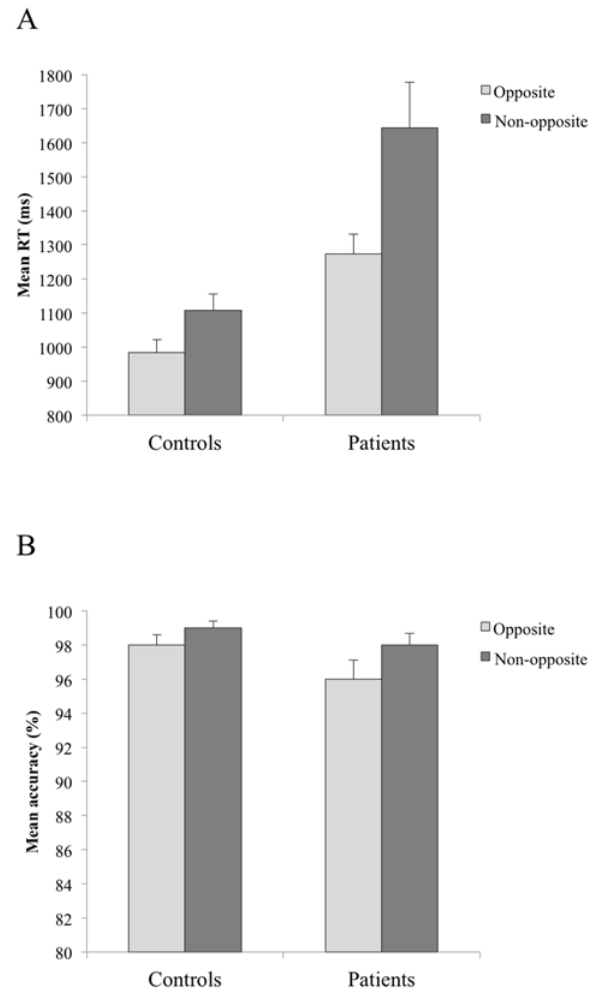
Figure 1. Mean reaction times ( A ) and mean percentage of correct responses ( B ) for controls and patients in opposite (bright gray bar) and non-opposite (dark gray bar) conditions. Bars represent standard errors of the